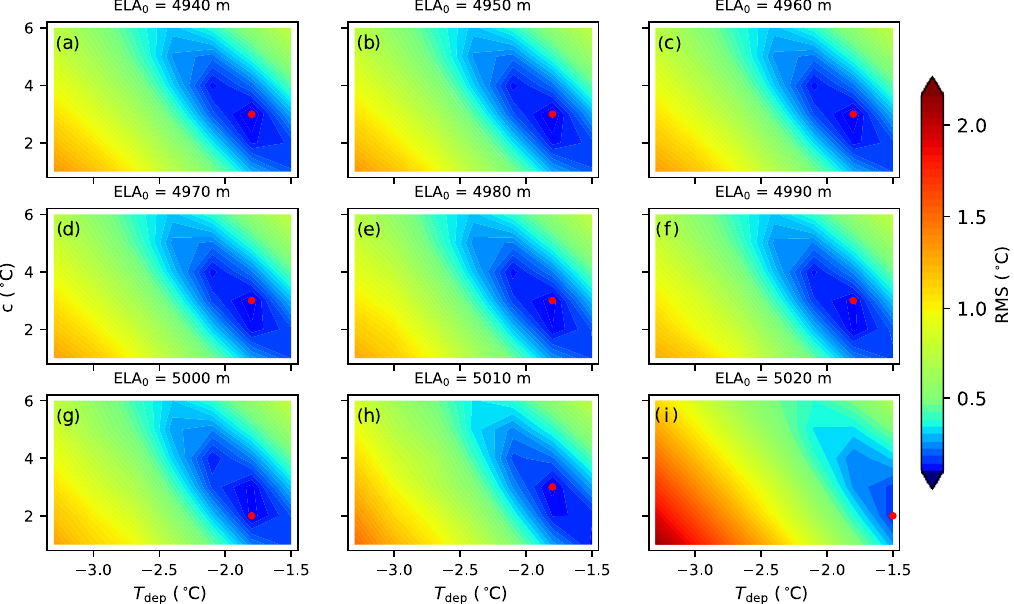
Figure 7. Root mean square (RMS) of differences between measured and modelled temperature profiles in the deep borehole. The red circle indicates the minimum of RMS. The parameter T dep is varied from − 3 . 3 to − 1 . 5 ◦ C with a step-size of 0 . 3 ◦ C, while c is varied in the range